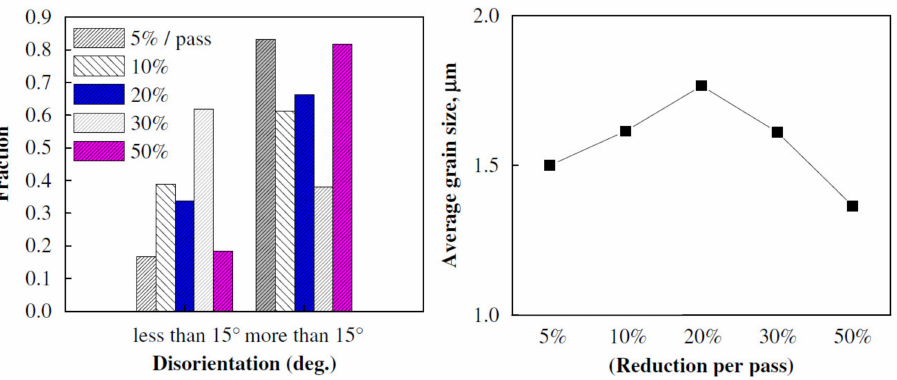
Figure 32. Disorientation distributions and average grain sizes in AA1050 sheets asymmetrically rolled by 93% after annealing at 195 ◦ C for 60 min (thickness reduction from 4.2 mm to 0.3 mm, speed ratio S R ≈ 2.0 due to different diameters of work rolls of 248 mm and 128 mm), reproduced from [79], with permission from Elsevier,